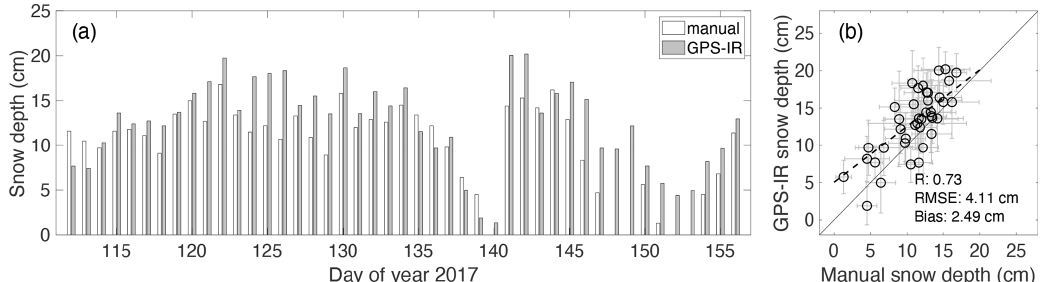
Figure 9. (a) Bar plot of manual and GPS-IR-estimated snow depth. Error bars are not shown for clarity. (b) Scatter plot of the manual snow depth and the GPS-IR ones and their best linear fit as a dashed line. The correlation coefficient ( R ), RMSE, and bias are shown as well.